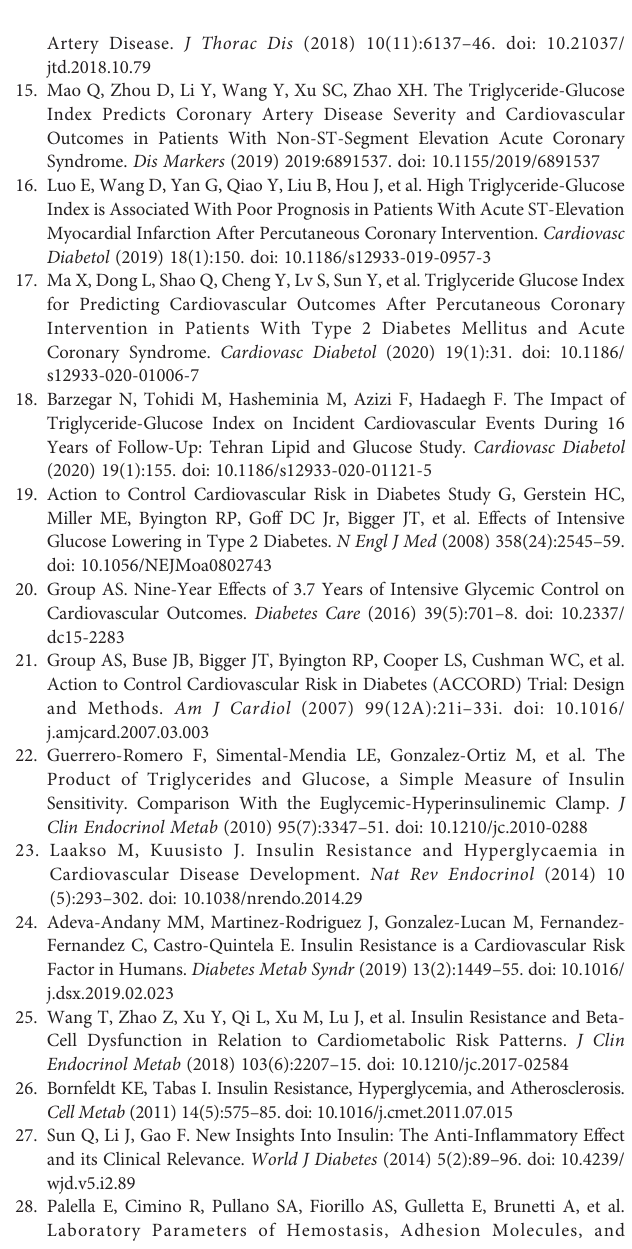
Supplementary Table 3 | TyG index at examination visits by trajectory groups of TyG index. TyG,